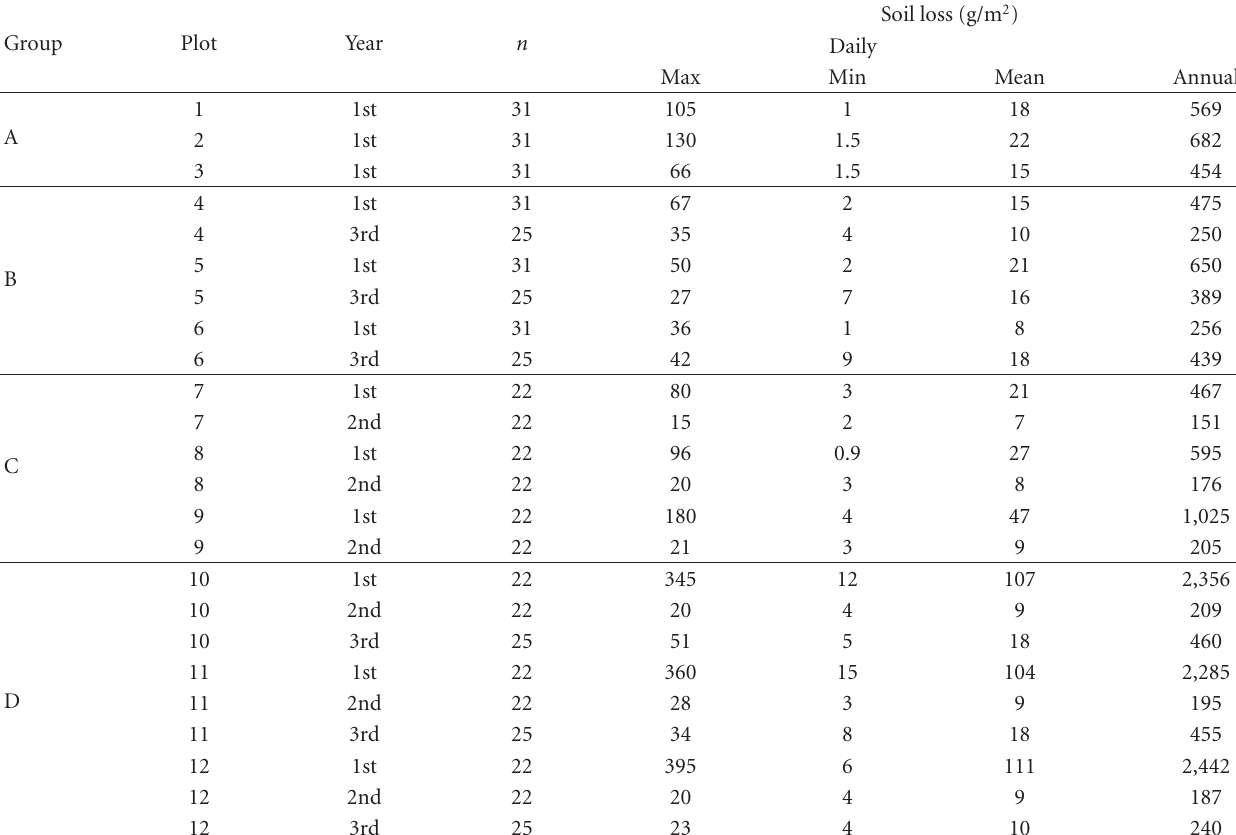
Table 4: Daily and annual soil loss recorded during the rainy seasons of each year. Group Plot